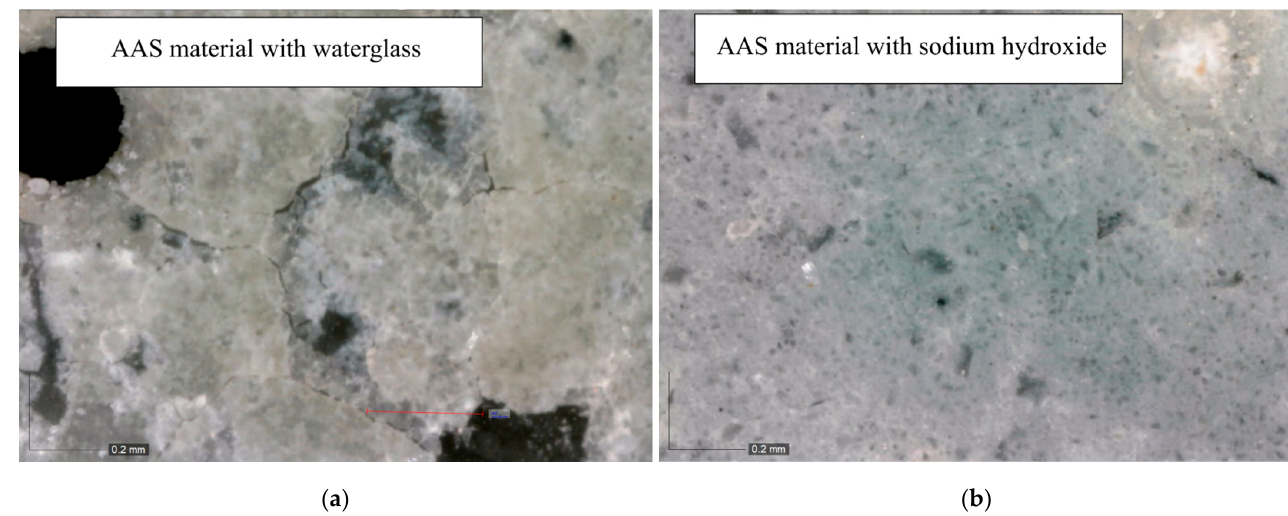
Figure 1. The surface of the alkali-activated slag (AAS) materials with a different activator (waterglass ( a ) and sodium hydroxide ( b )) cured in relative humidity ( RH) ≥ 95% (240× magnification).